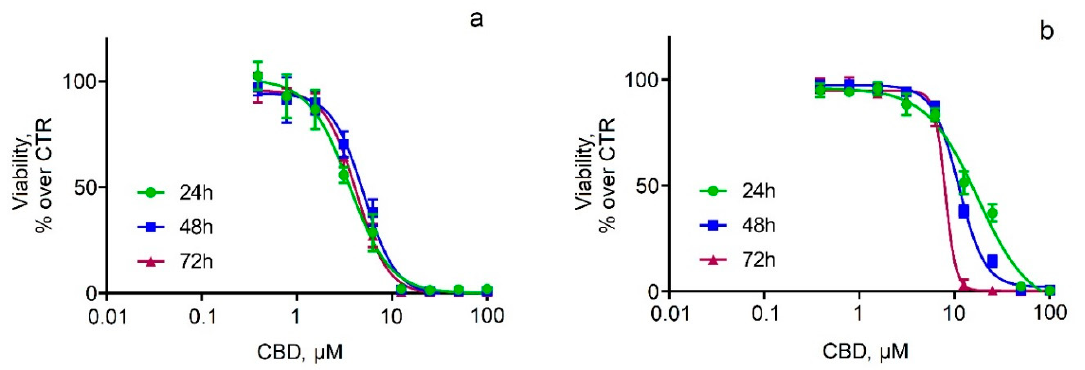
Figure 5. Cytotoxic effects after treatment of SH-SY5Y cells ( a ) and Neuro-2a cells ( b ) with pure CBD. Values are presented as the percentage of untreated controls and expressed as mean ± SD ( n = 6).